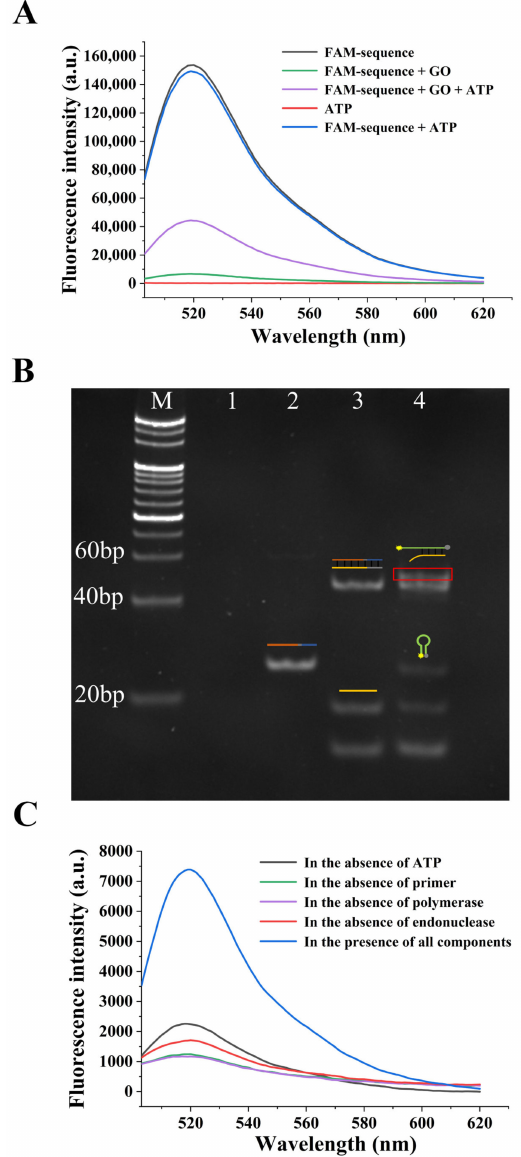
Figure 3. Verification of the practicability of the aptasensor. ( A ) Fluorescence emission spectra obtained in different conditions. The concentrations of the FAM-sequence and ATP were 2 µ M and 1 mM, respec- tively. The amount of graphene oxide (GO) was 5 µ L. ( B ) Polyacrylamide gel electrophoresis (PAGE) image for verification of the results under various experimental conditions. Lane M: DL20 DNA marker; lane 1: 2 µ M chimera sequence and 5 µ L GO; lane 2: 2 µ M chimera sequence, 5 µ L GO and 1 mM